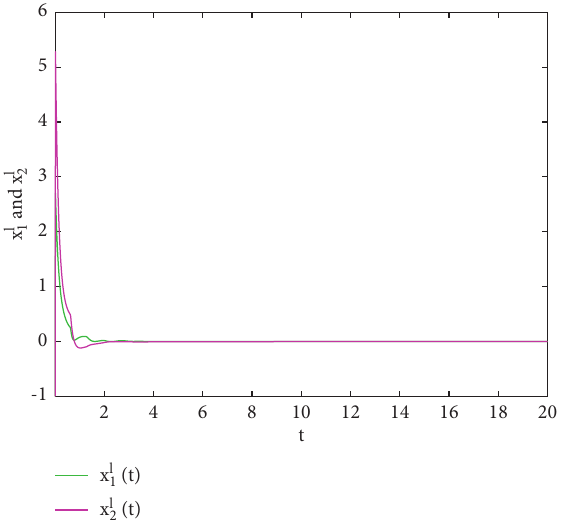
Figure 2: Imaginary parts of the transient states of system (65).